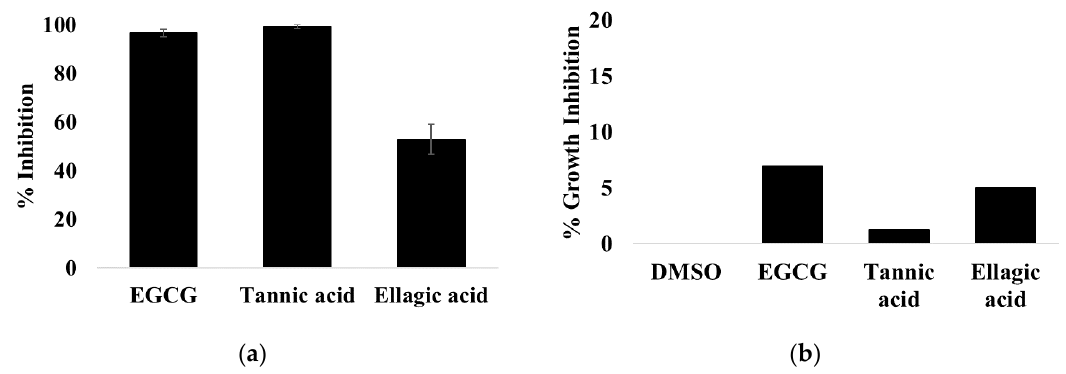
Figure 5. EGCG, tannic acid, and ellagic acid were screened for T3SS inhibitory activity at 50 μ M. ( a ) EGCG and tannic acid appear to be more potent inhibitors than ellagic acid. ( b ) The compounds were not cytotoxic.